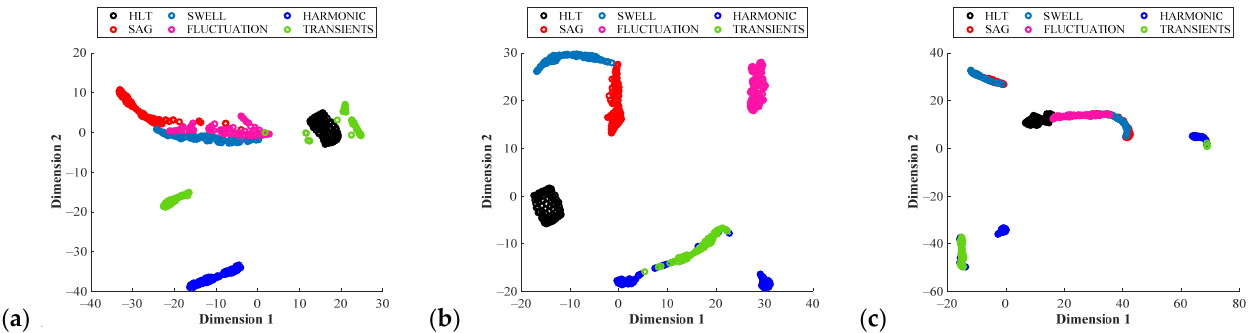
Figure 7. 2- d visual representation of the data distribution performed by the T-SNE technique over the resulting SOM neuron grid models for all considered conditions when analyzing: ( a ) SOM neuron grids models for TD, ( b ) SOM neuron grids models for FD and ( c ) SOM neuron grids models for TFD.